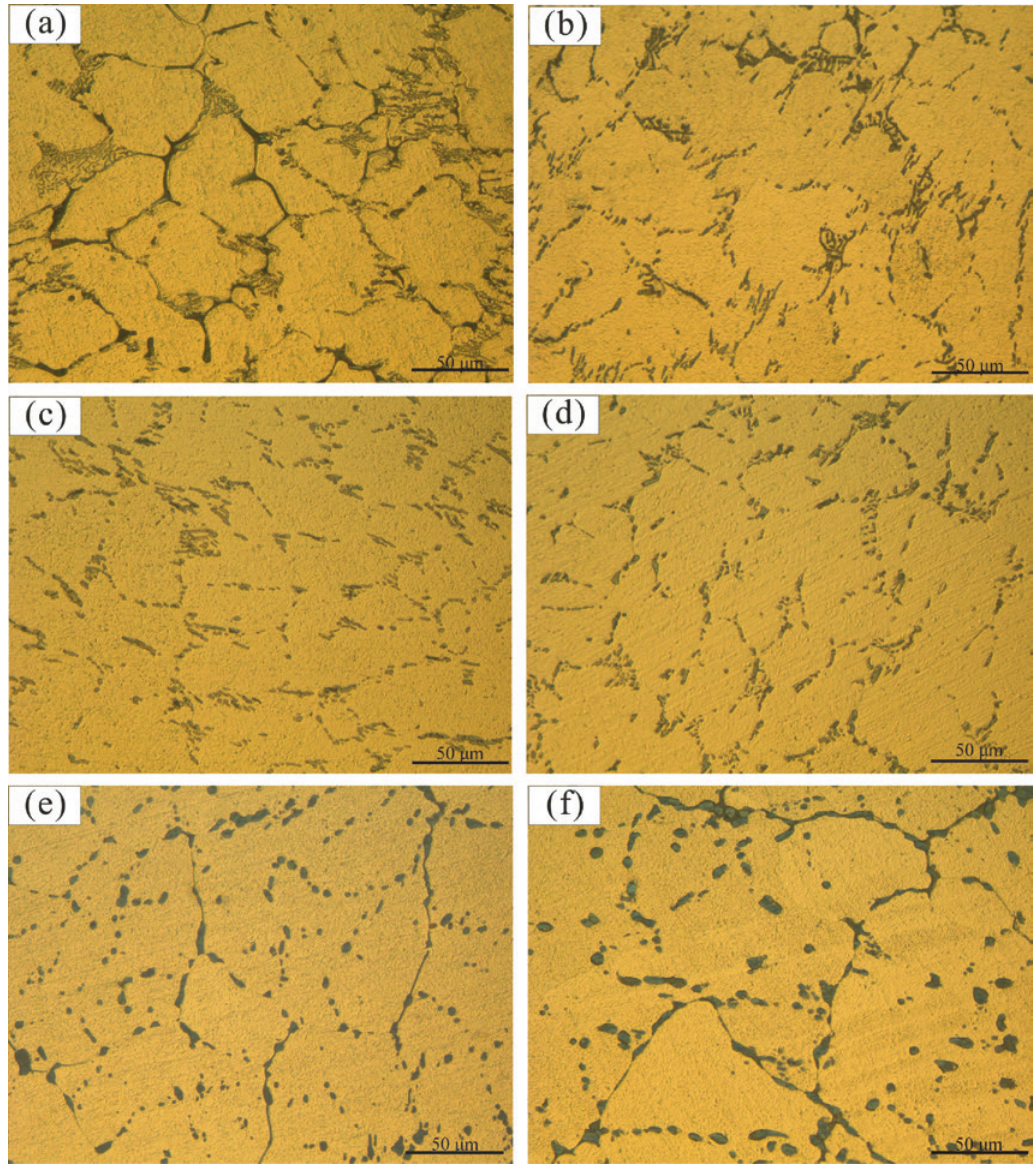
Fig. 3: Optical microstructure of as-cast alloy 2618 and the alloys homogenized at different temperatures for 24 h, respectively: (a) as-cast; (b) 480 °C; (c) 490 °C; (d) 500 °C; (e) 510 °C; (f) 520